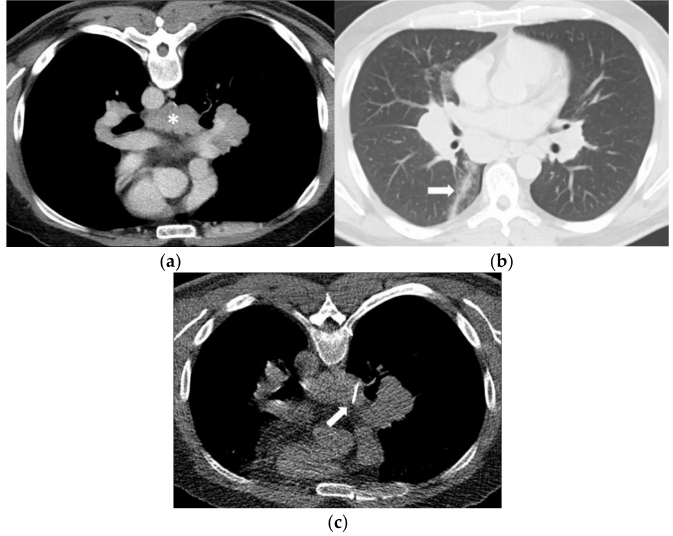
Figure 3. ( a ) A 48-year-old man evaluated for suspicion of lymphoma with marked mediastinal and bilateral hilar lymphadenopathy. The infracarinal mediastinal lymph node bulk (asterisk) was chosen for CT-guided biopsy after unsuccessful transbronchial fine-needle aspiration biopsy. ( b ) Using a right paravertebral transpulmonary access under CT fluoroscopy guidance, an 18-Gauge Tru- Cut biopsy needle (arrow) was inserted into the infracarinal lymph node. Histopathology revealed a granulomatous lymphadenitis in line with sarcoidosis. ( c ) Unenhanced CT after the biopsy in supine position shows a small alveolar hemorrhage along the access path (arrow) and a discrete